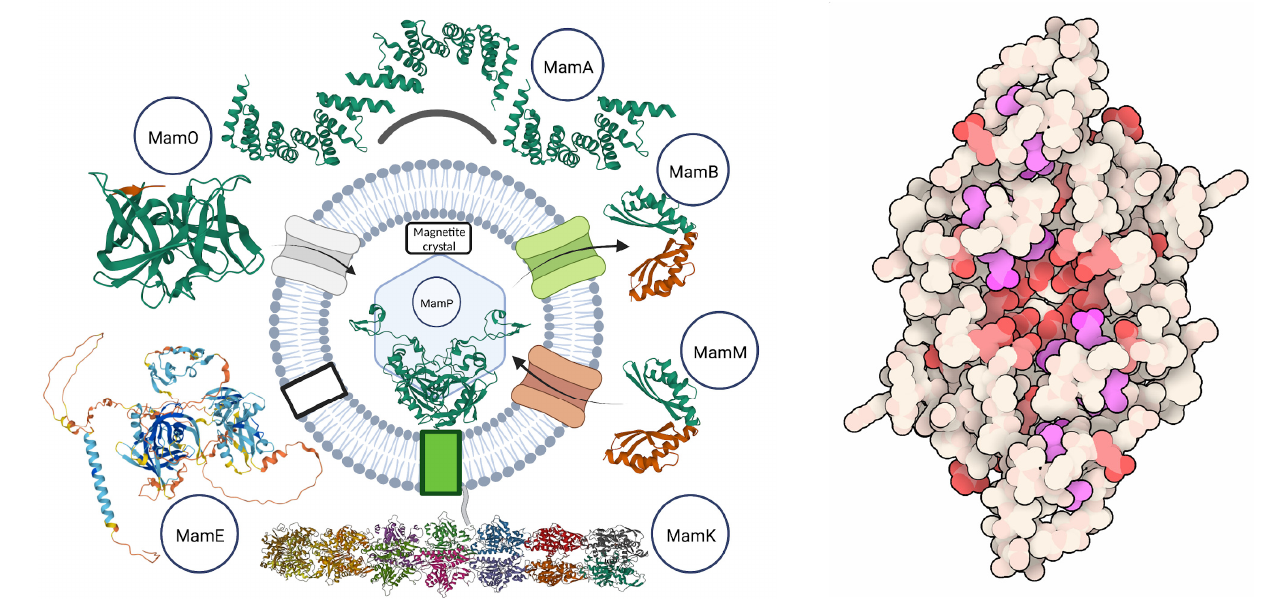
Figure 5. ( Left panel ) Graphical representation of known 3D structures of magnetite biomineral- ization proteins: adapted from ref. [104], for the purpose of this review. Magnetosome encircled membrane and a magnetite crystal are shown with grey shapes. Magnetosome proteins are repre- sented as ribbon plot and correspond to PDB codes reported in Table 1. MamA function as a protein scaffold for guidance of biomineralization proteins assembly. MamB and MamM have similar shapes and represent transport proteins of iron ions and protons through cellular membrane and in an opposite flow direction. MamK functions as an anchoring string for the alignment of magnetosomes and to enhance the overall magneto sensing function. MamE and MamO are two proteases mutually regulated, and together with MamD, a protein tightly bound to the mineral, regulate crystal formation and growth. In addition, MamO has a metal binding activity [58]. The MamE model is derived from the AlphaFold project [41]. Figure made with BioRender (https://biorender.com/; accessed on 1 June 2022). ( Right panel ) MamP is a modular protein composed of a central domain linked to two consecutive magnetochrome domains [59]. The central domain brings together acidic glutamate amino acids to form a pocket where iron nucleation is initiated. The hemes in magnetochrome domains (purple color), are similar to cytochrome c, and shuttle electrons to switch the oxidation state of the iron atoms as they are combined with oxygen in the growing magnetite crystal. Negatively charged resides are represented in red. This figure is obtained from the Molecule of the Month column “Proteins and Biominerals” (Di Costanzo, L; Goodsell, D. 10.2210/rcsb_pdb/mom_2019_4)